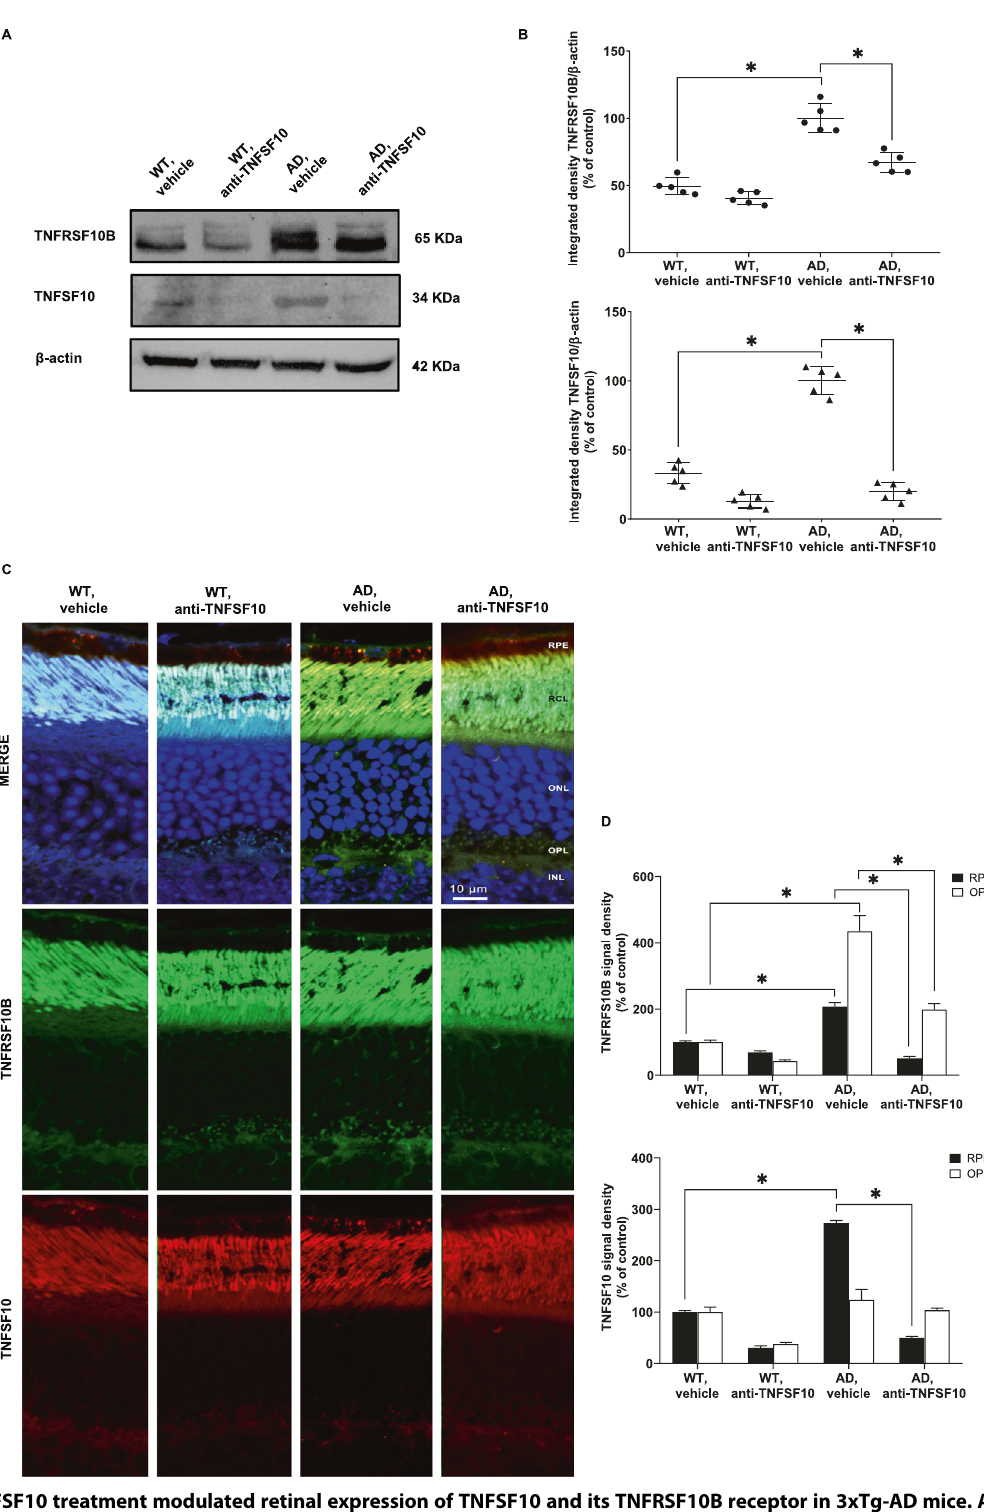
Fig. 5 Anti-TNFSF10 treatment modulated retinal expression of TNFSF10 and its TNFRSF10B receptor in 3xTg-AD mice. A Immunoblots of retinal lysates for the expression of TNFRSF10B and TNFSF10 proteins. B Densitometric analysis of western blots. Data are expressed as mean ± standard deviation. One-way ANOVA and post-hoc Tukey ’ s multiple comparisons test were used for statistical analysis. * p < 0.05. N = 5 animals; 5 independent retinal samples, 2 pooled retinas per sample in each group. C Immunohistochemical staining for TNFSF10 and its receptor TNFRSF10B in the retina of WT and 3xTg-AD mice, treated either with vehicle or anti-TNFSF10 antibody. Original magni fi cation, x63. Scale bar = 10 µm. D Densitometric analysis of the TNFRSF10B and TNFSF10 immuno fl uorescence signal in the RPE and OPL retinal layers. Data are expressed as mean ± standard deviation. One-way ANOVA and post-hoc Tukey ’ s multiple comparisons test were used for statistical analysis. * p < 0.05. N = 5 animals; 5 independent retinal samples per group. For each retinal section, 14 optical fi elds were analyzed.